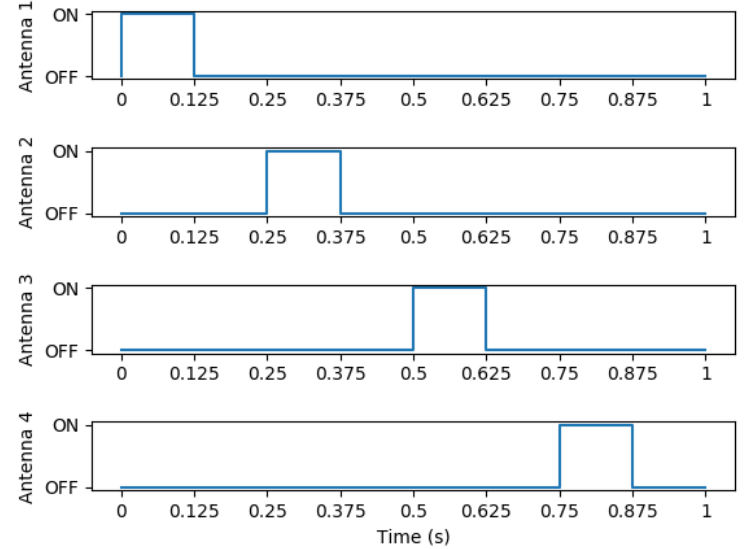
Figure 9. The structure of a duty cycle of the RFID reader operation. It is only possible to power one antenna at a time and all antennas must be off for a given time as well. The time span during which each pair of antennas (Figure7) operate can be tailored to how fast the bee species under study